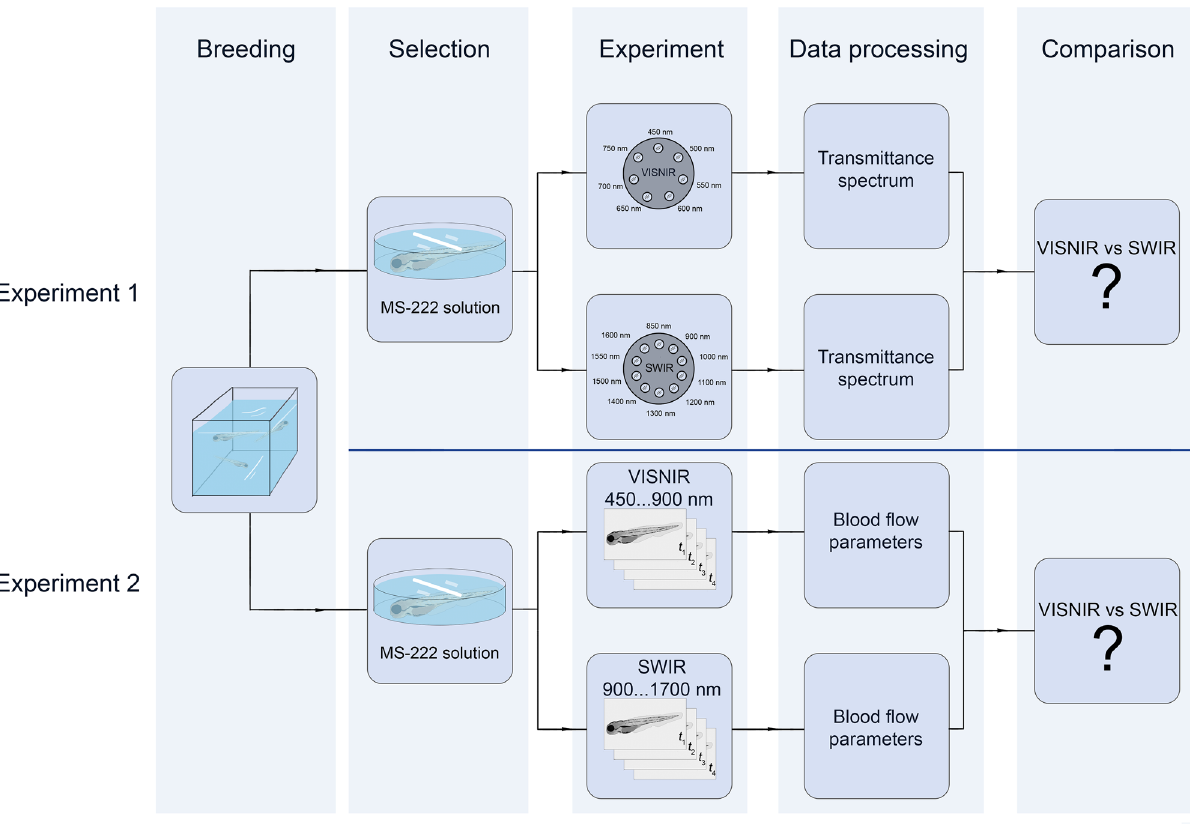
Figure 1. Experimental protocol. It consists of two sequential stages. In experiment 1, we measured the optical transparency of zebrafish tissues in the 450–1700 nm spectral range. In experiment 2, we calculated the parameters of the cardiovascular system in VISNIR and